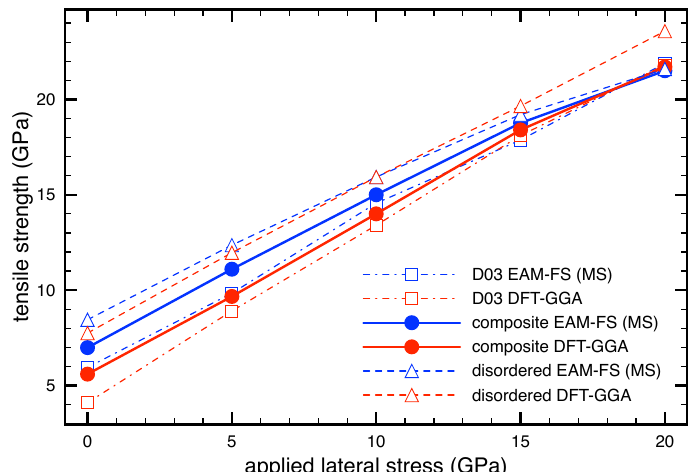
Figure 3. The effect of the transverse stresses on the tensile strength as studied by quantum-mechanical calculations (marked as DFT-GGA) and atomistic Embeded Atom Method (EAM) potentials (marked as